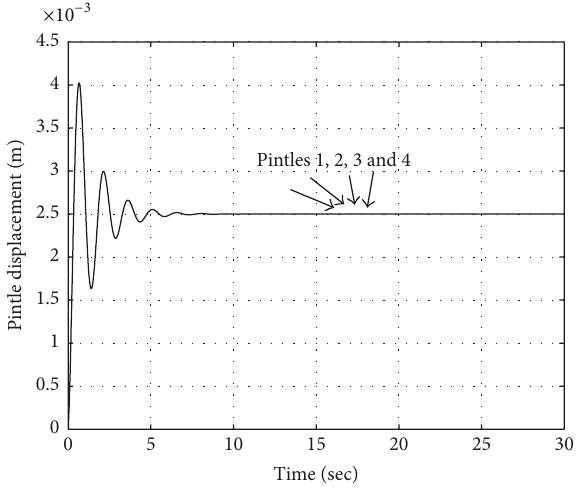
Figure 16: Simulation results, case (2).